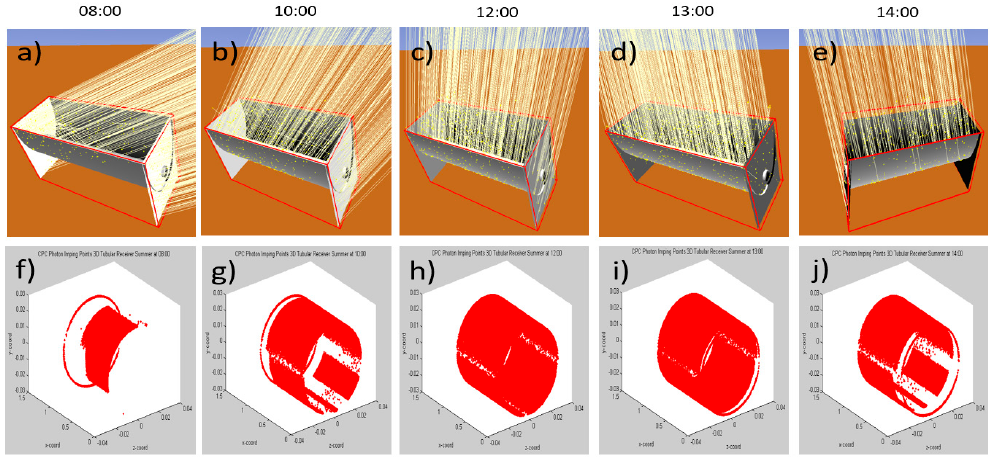
Figure 6. Evolution of ( a – e ) shading and ( f – j ) photon impacts on the receiver for summer solstice from 8 to 14 h, for a static setup (21°).